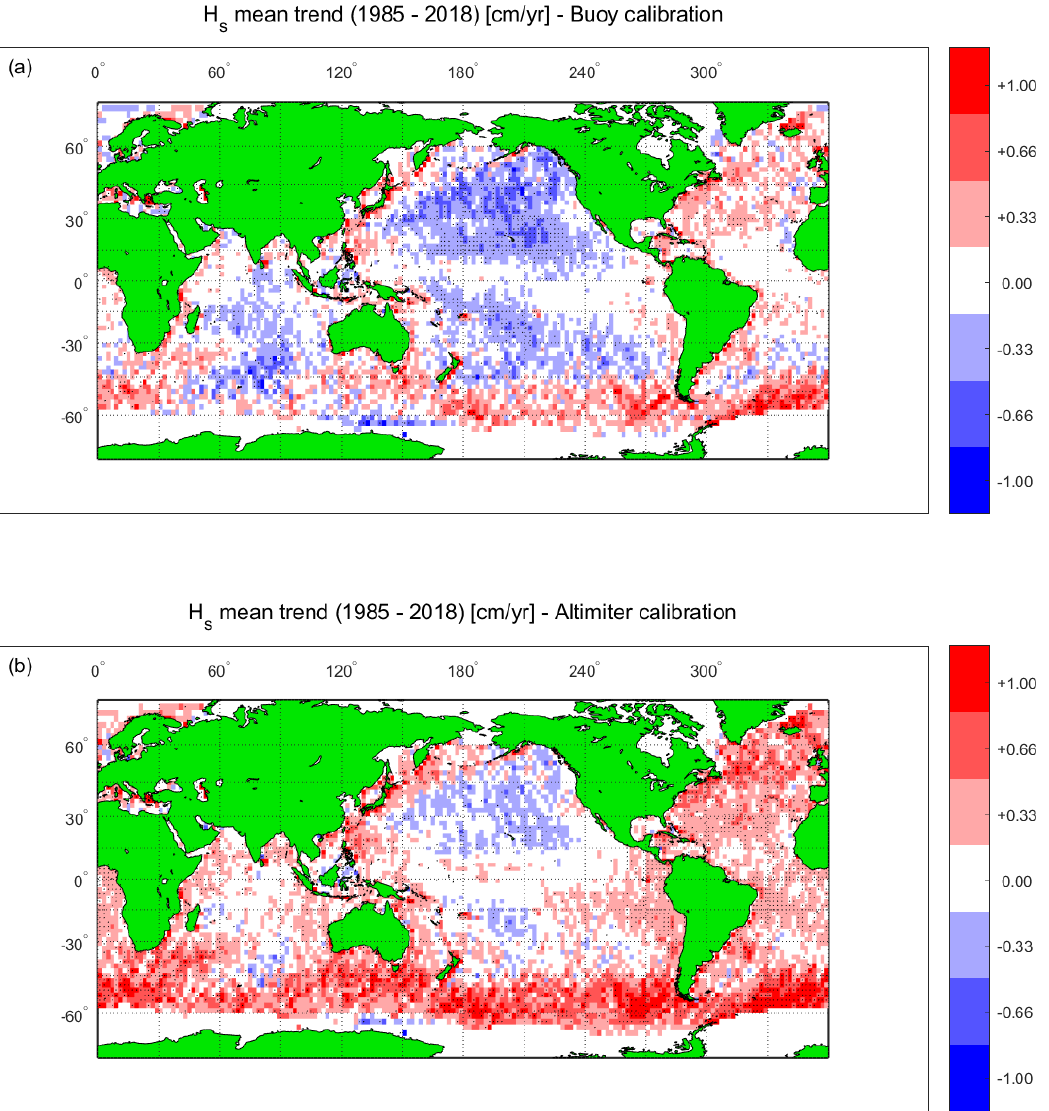
Figure 4. Trends in values of mean monthly significant wave height, H s (units–cm/year) from altimeter data over the period 1985 to 2018. Multi-mission altimeter dataset calibrated using ( a ) “altimeter–buoy” calibration and ( b ) “altimeter–altimeter” calibration. Values which are statistically significant at the 95th percent level are shown by small